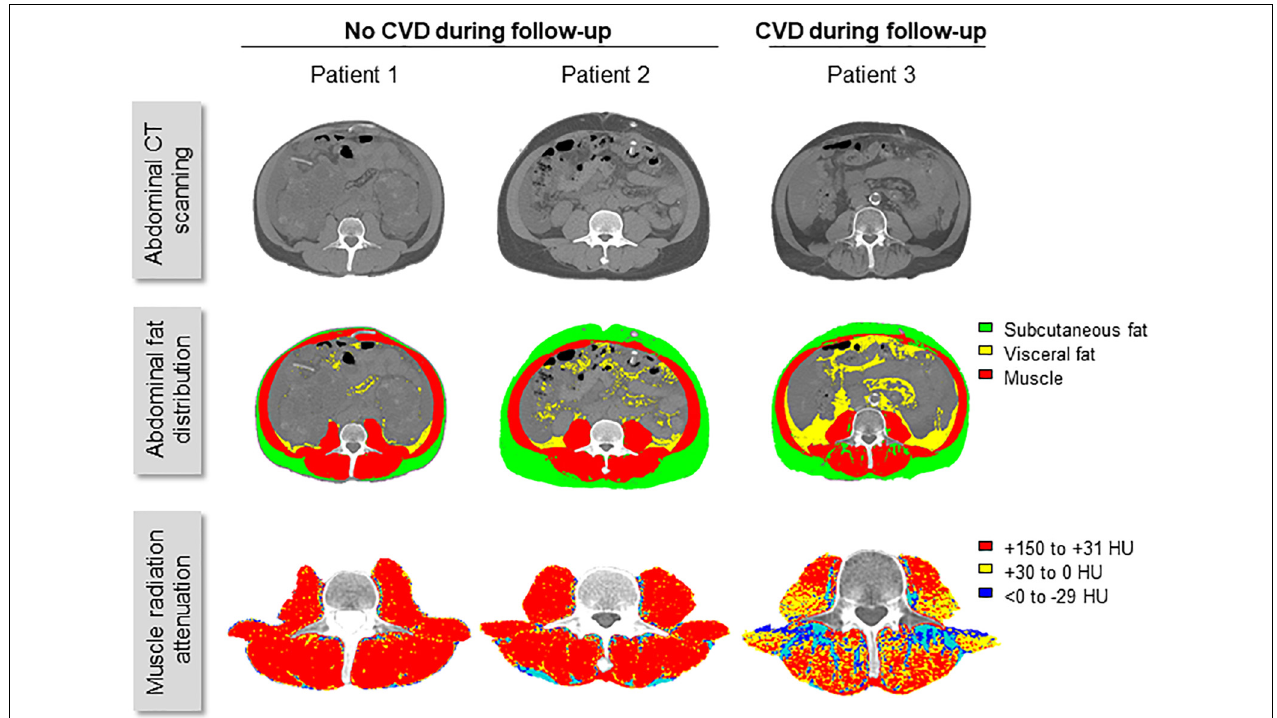
FIGURE 1 | Fat distribution and the risk of CVD events in patients with kidney failure. Representative images of CT scan of the abdomen and analysis of fat distribution and muscle radiation attenuation (MRA) obtained at dialysis initiation from three male patients, matched for age, body-mass index, and residual urine volume. Age at CT scan was 52, 49, and 52-year-old; and body-mass index, 20.0, 21.4, and 19.4 kg/m 2 , for patients 1, 2, and 3, respectively. Urine output was > 1000 ml/day in all three patients. Despite similar clinical characteristics, mean MRA was 50.4, 50.9, and 22.7 HU, in patients 1, 2, and 3, respectively. Patient 3 presented cardiovascular disease (CVD) events during follow-up, in contrast to patients 1 and 2, who did